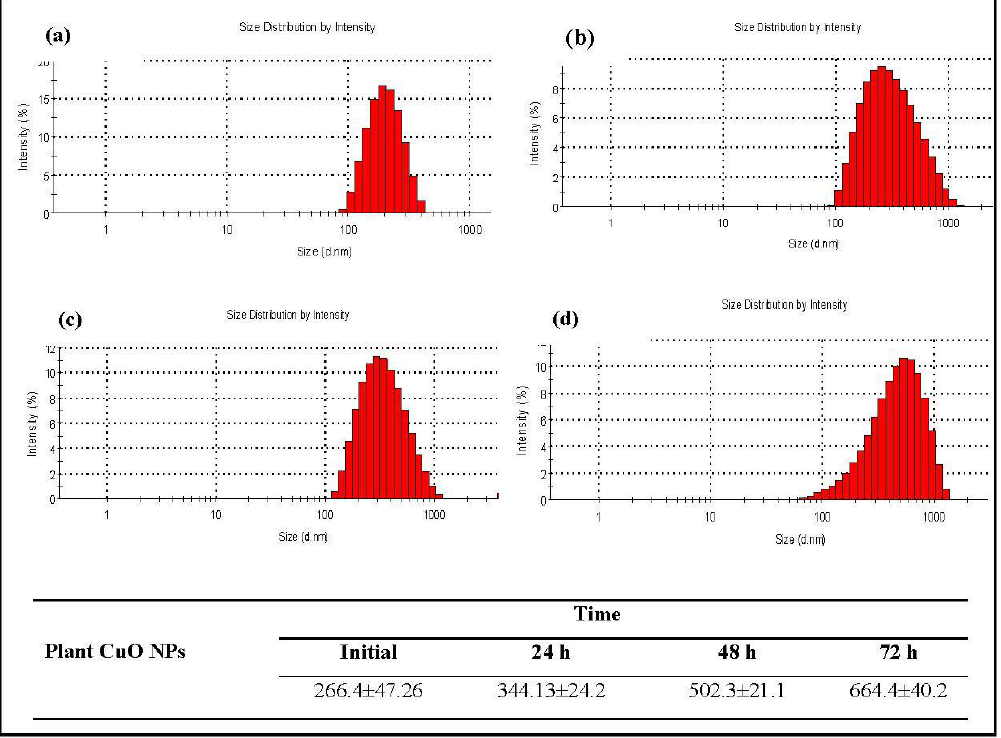
Figure 7. Size and size distribution of plant-synthesized nanoparticles ( a ) initial; ( b ) 24 h; ( c ) 48 h and ( d ) 72 h.